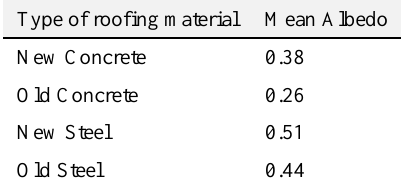
Table 2. Mean albedo of various types of roofing materials CONCLUSION